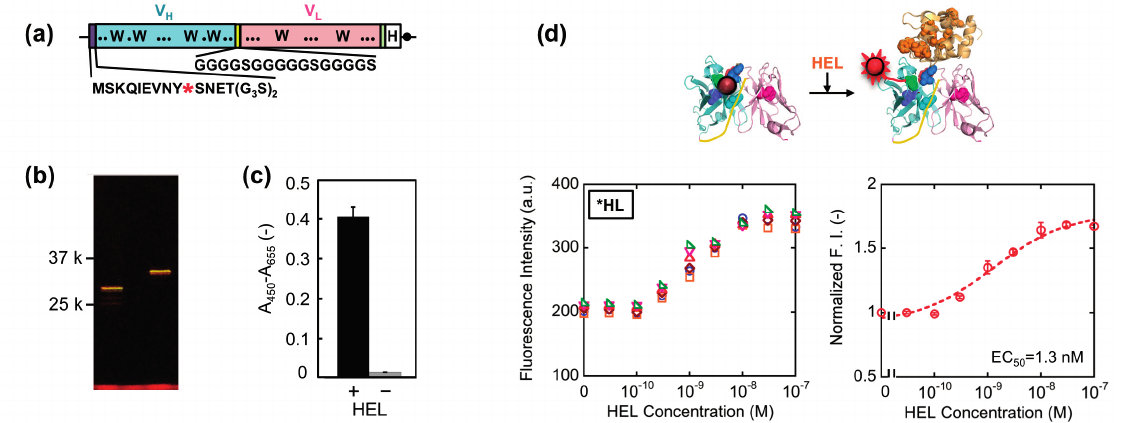
Figure 2. ( a ) Scheme of *HL type HEL Q-body gene. Asterisk denotes an amber codon; ( b ) Fluorescence image of SDS-PAGE for the expressed *HL type HEL Q-body in non-reducing (left) and reducing (right) conditions; ( c ) Specific binding of HEL Q-body to HEL, probed by ELISA. Error bars represent ±1 standard deviation (SD) (n = 3); ( d ) Conceptual drawing of the de-quenching of the Q-body (upper), and titration curves of the fluorescence intensity (lower left) and normalized fluorescence intensity (lower right) of *HL type Q-body. Error bars represent ±1 SD (n =